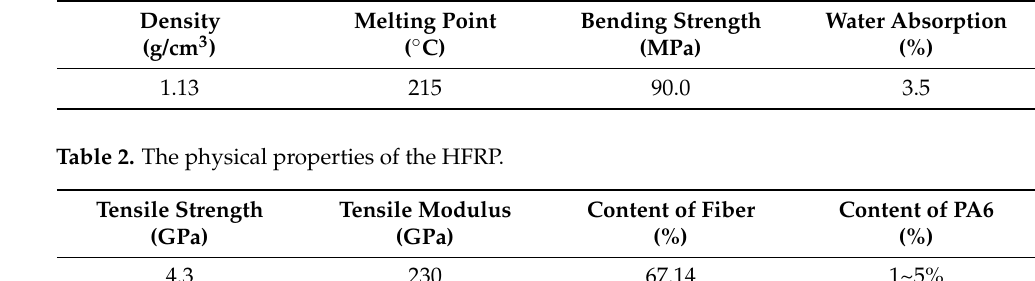
Table 1. The physical properties of the PA6.